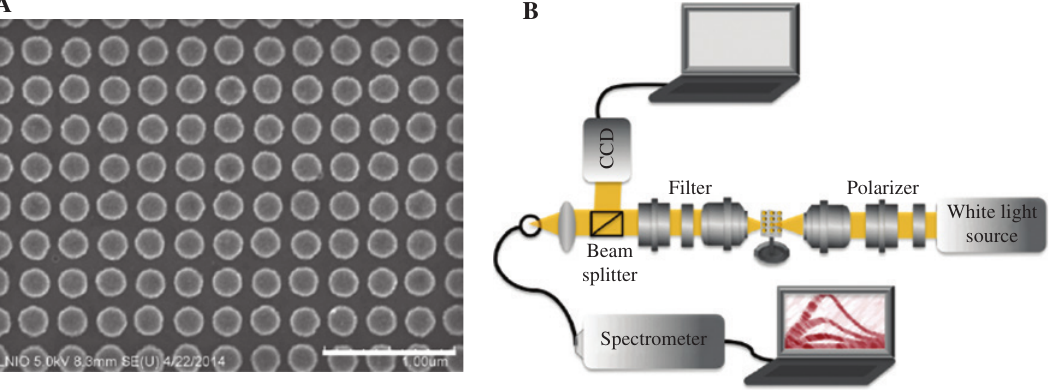
Figure 2: (A) SEM image of the grating of, gold nano-cylinders; the scale bar is 1 μ m. The experimental set-up for angle-resolved extinction measurements is presented in